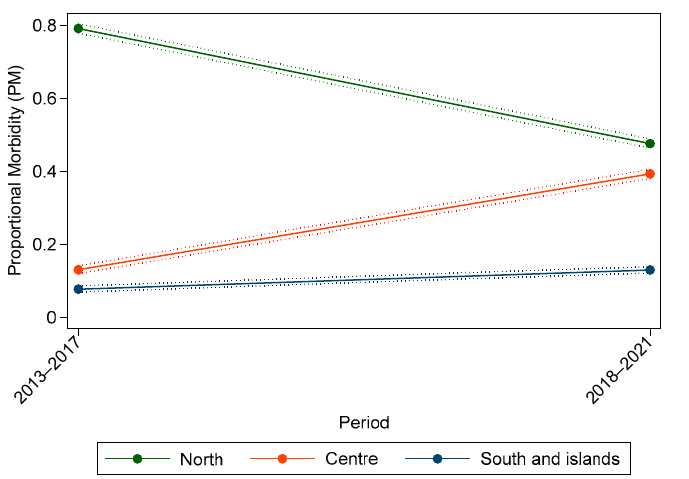
Figure A6. Proportional morbidity ratios of benign tumours by topography comparing benign tu- mours diagnosed in Centre ( a ) and South and Island ( b ) with Northern Italian regions. Dots: age- class-adjusted PMR, bars: lower and upper bound of 95% confidence interval. A vertical reference line indicates PMR = 1.